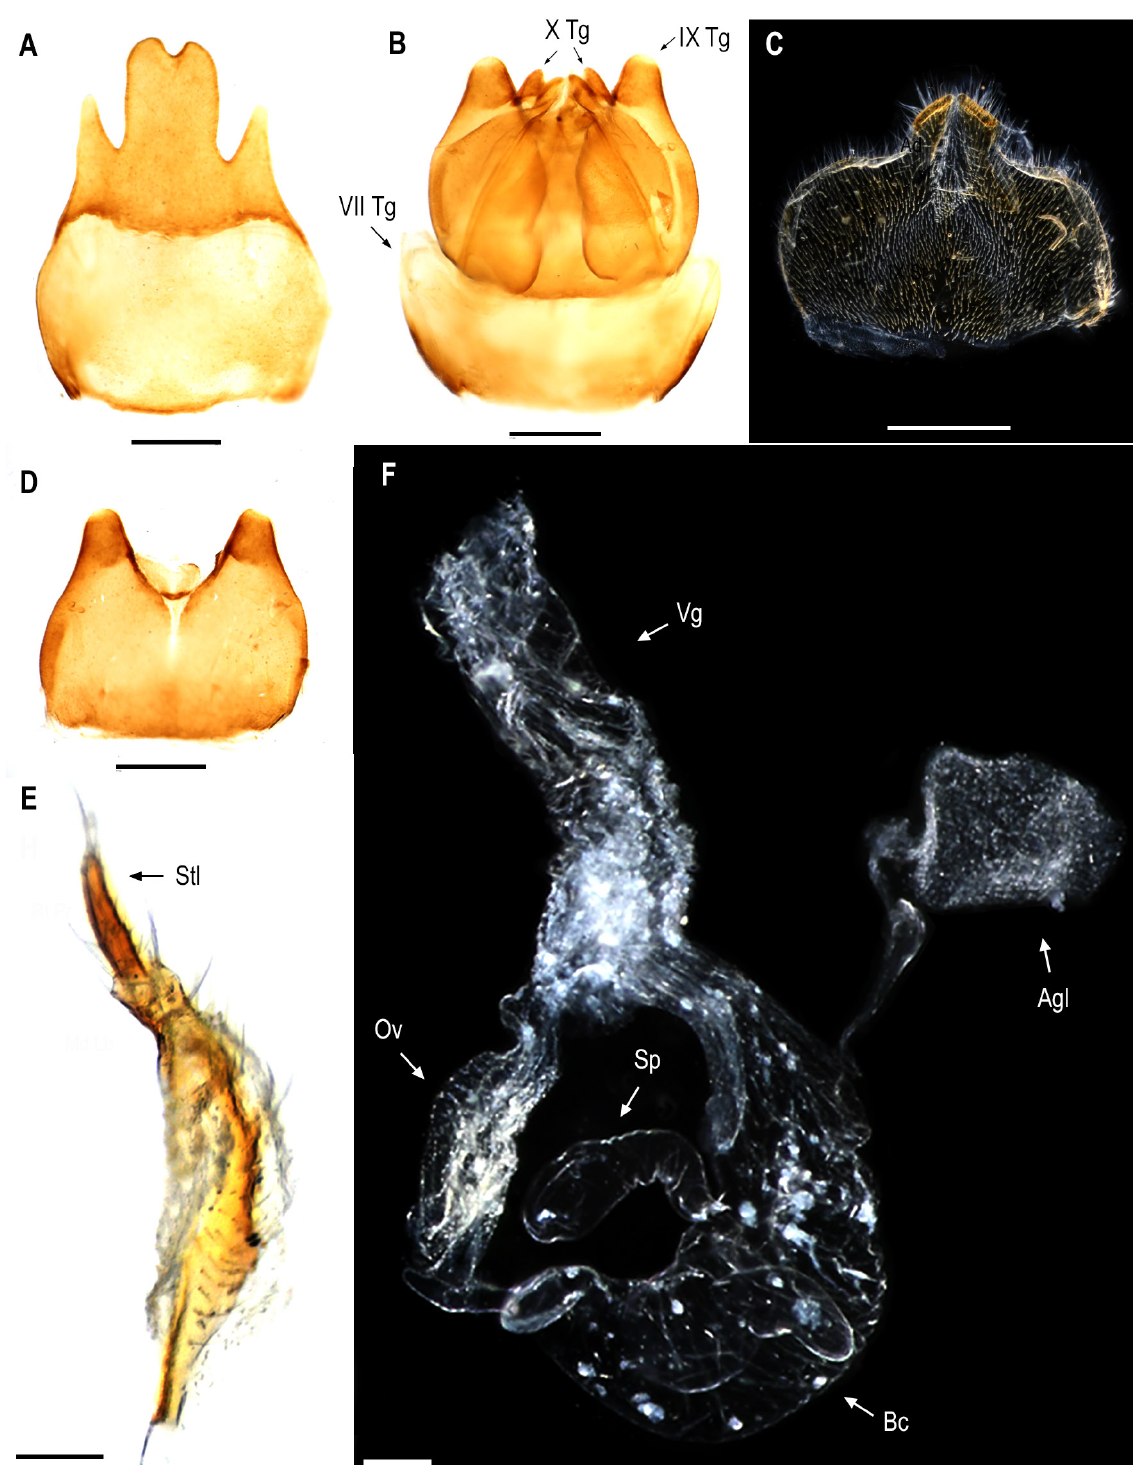
Fig. 5. Micro images (brightfield and darkfield) of Trypheridium kashmiricum sp. nov. ♀, paratype (KUIC 0015), terminal segments and genitalia. A . Sternite VII. B . Terminal segments (ventral view) with sternite VII removed. C . Sternite VIII. D . Tergite VIII. E . Coxite. F . Membranous genitalia. Abbreviations: VII Tg = tergite VII; IX Tg = tergite IX; X Tg = tergite X; Agl = accessory gland; Bc = bursa copulatrix; Ov = oviduct; Sp = spermatheca; Stl = style; Vg = vagina. Scale bars: A–D = 0.5 mm; E–F = 0.1 mm.